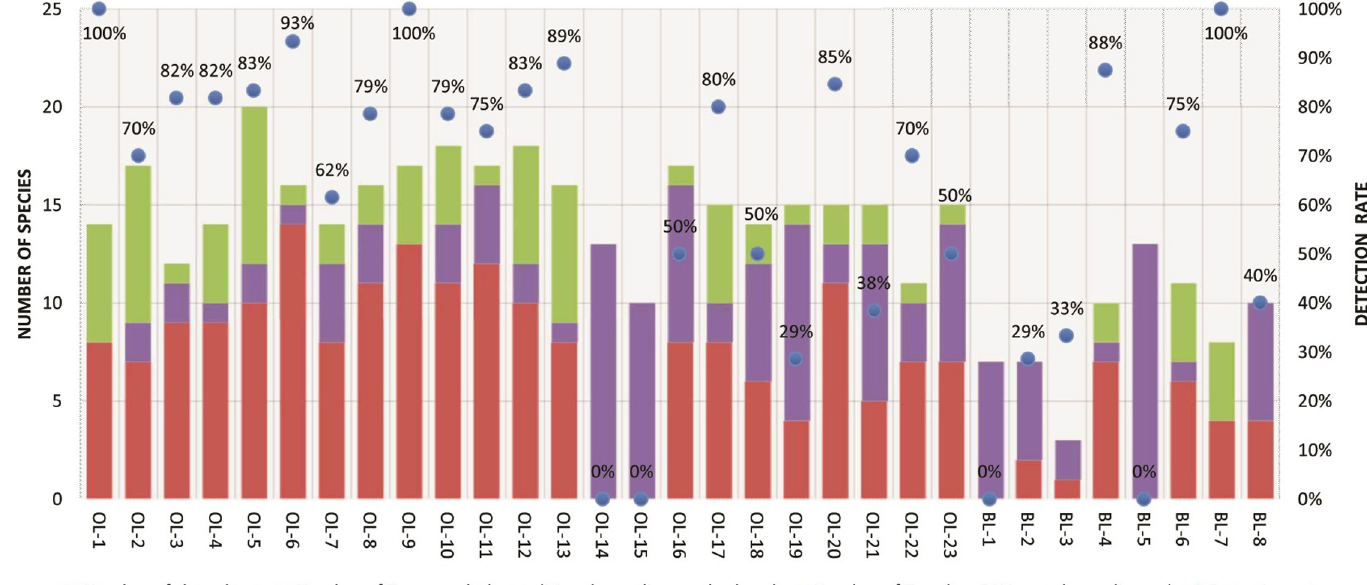
Fig 4. Species number and detection rate compared between eDNA metabarcoding and capture methods.